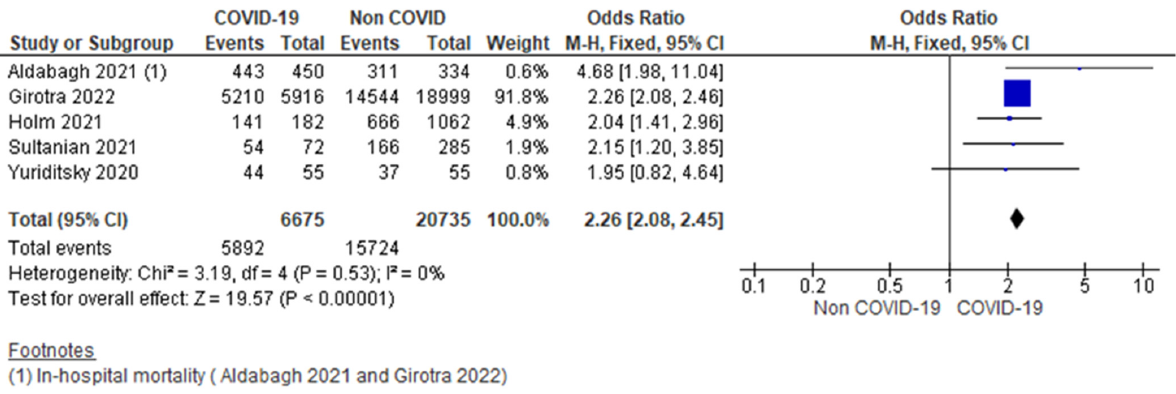
Figure 6. Forest plot showing group di ff erences on 30-day mortality among COVID-19 versus non- COVID-19 patients using fi xed e ff ect model. [12–16].